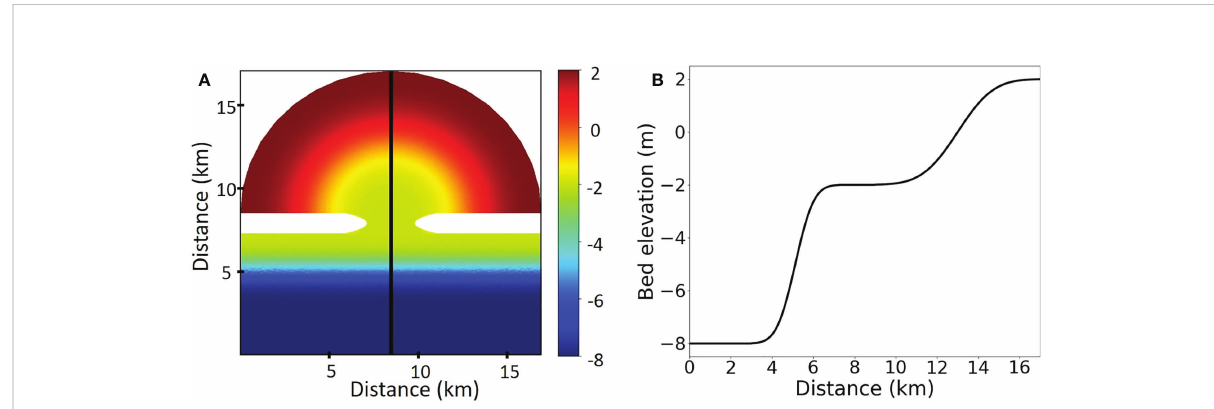
FIGURE 1 The initial bathymetry (unit: m) used in this study shown in aerial perspective (A) and cross-shore along the center line (B) . The blank areas in (A) indicate unerodible lands above the water